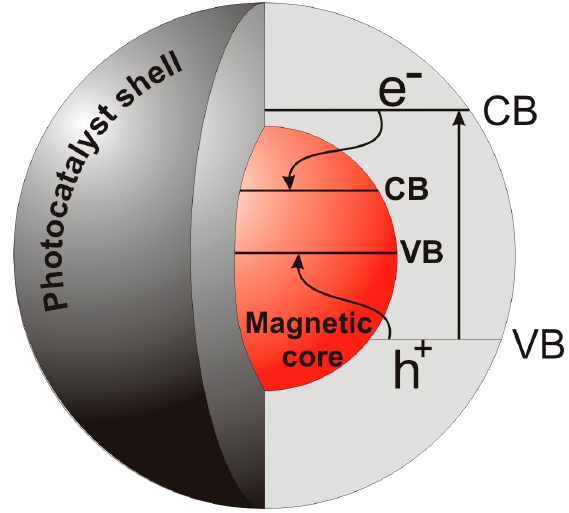
Figure 1. Recombination of charge carriers and photodissolution of Fe 3 O 4 during irradiation of magnetic core and TiO 2 shell photocatalyst.